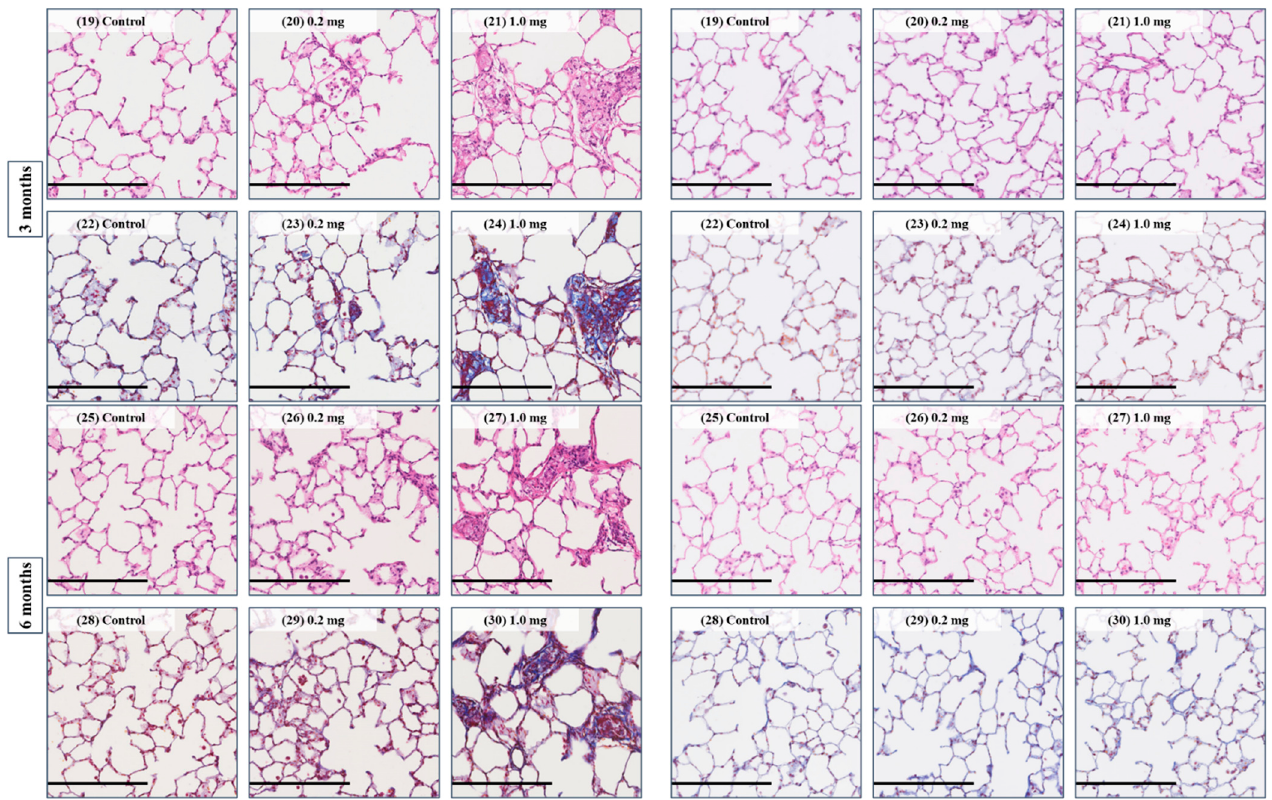
Figure 7. Comparison of histological findings between HMW PAA-exposure group and LMW PAA- exposure group (Hematoxylin and eosin (HE) and Masson trichrome (MT) staining). ( A ) HMW PAA-exposure group and ( B ) LMW PAA-exposure group. At 3 days HE staining, where ( 1 ) control group, ( 2 ) 0.2 mg-exposure group, and ( 3 ) 1.0 mg-exposure group; and MT staining, where ( 4 ) control group, ( 5 ) 0.2 mg-exposure group, and ( 6 ) 1.0 mg-exposure group. At 1 week HE staining, where ( 7 ) control group, ( 8 ) 0.2 mg-exposure group, and ( 9 ) 1.0 mg-exposure group; and MT staining, where ( 10 ) control group, ( 11 ) 0.2 mg-exposure group, and ( 12 ) 1.0 mg-exposure group. At 1 month HE staining, where ( 13 ) control group, ( 14 ) 0.2 mg-exposure group, and ( 15 ) 1.0 mg-exposure group; and MT staining, where ( 16 ) control group, ( 17 ) 0.2 mg-exposure group, and ( 18 ) 1.0 mg-exposure group. At 3 months HE staining, where ( 19 ) control group, ( 20 ) 0.2 mg-exposure group, and ( 21 ) 1.0 mg-exposure group; and MT staining, where ( 22 ) control group, ( 23 ) 0.2 mg-exposure group, and ( 24 ) 1.0 mg-exposure group. At 6 months HE staining, where ( 25 ) control group, ( 26 ) 0.2 mg-expo- sure group, ( 27 ) 1.0 mg-exposure group. MT staining; ( 28 ) control group, ( 29 ) 0.2 mg-exposure group, and ( 30 ) 1.0 mg-exposure group. In the HMW PAA-exposure group, lung inflammation, in- cluding infiltration of neutrophils in alveoli (red arrow heads in inset), persisted for 1 month, and pulmonary fibrosis observed after 3 days after the instillation was observed throughout the obser- vation period. In the LMW PAA-exposure group, on the other hand, lung inflammation lasted only for 1 week or 1 month, and slight pulmonary fibrosis was observed at 3 days after the instillation, although it disappeared by 3 months. The extent of lung inflammation and fibrosis were more se- vere in the HMW PAA-exposure group than in the LMW PAA-exposure group. (Internal scale bar = 250 µm for all).